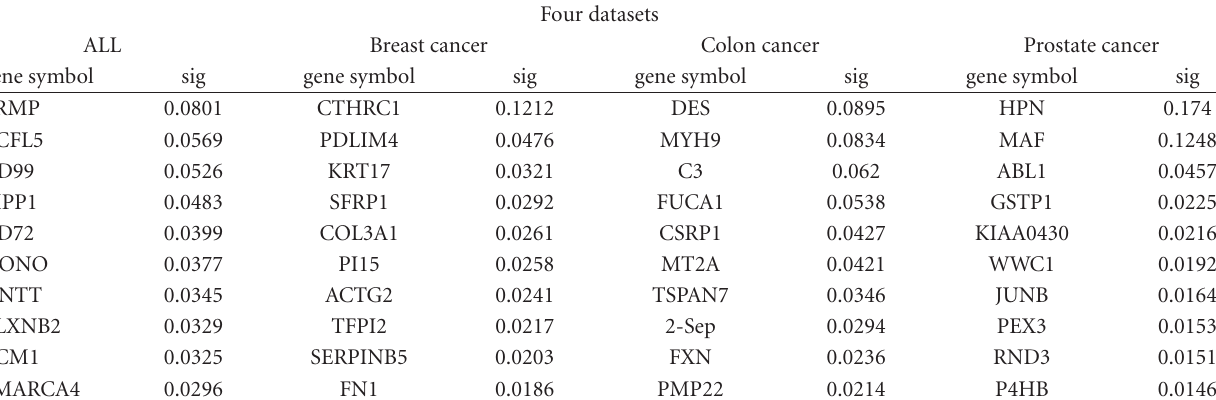
Table 4: The 10 top-ranked genes selected for the four datasets. Four datasets